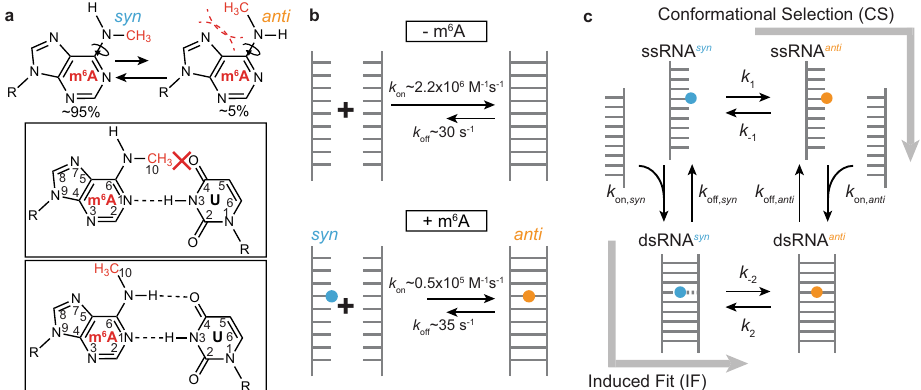
Fig. 1 The syn and anti isomers of m6A. a The m 6 A nucleobase shows a 20:1 preference for the syn isomer due to unfavorable steric interactions (shown in dashed red lines) in the anti isomer 12, 25 . In a duplex, the syn isomer impedes Watson – Crick pairing, and the anti isomer becomes the dominant form. b Apparent annealing ( k on ) and melting ( k off ) rate constants for unmethylated ( − m 6 A) and methylated ( + m 6 A) dsRNA. Rate constants shown were obtained from CEST measurements on dsGGACU with and without m 6 A at T = 65 °C 21 . c Schematic of the general four-state CS + IF model. k the forward and backward rate constants for methylamino isomerization in ssRNA, respectively; k 2 and k (cid:1) 2 are the forward and backward rate constants for methylamino isomerization in dsRNA, respectively; k and k are the annealing and melting rate constants, respectively, when m 6 A adopts anti on ; anti off ; anti conformation in both ssRNA and dsRNA; k on ; syn and k off ; syn are the annealing and melting rate constants, respectively when m 6 A adopts syn conformation in both ssRNA and